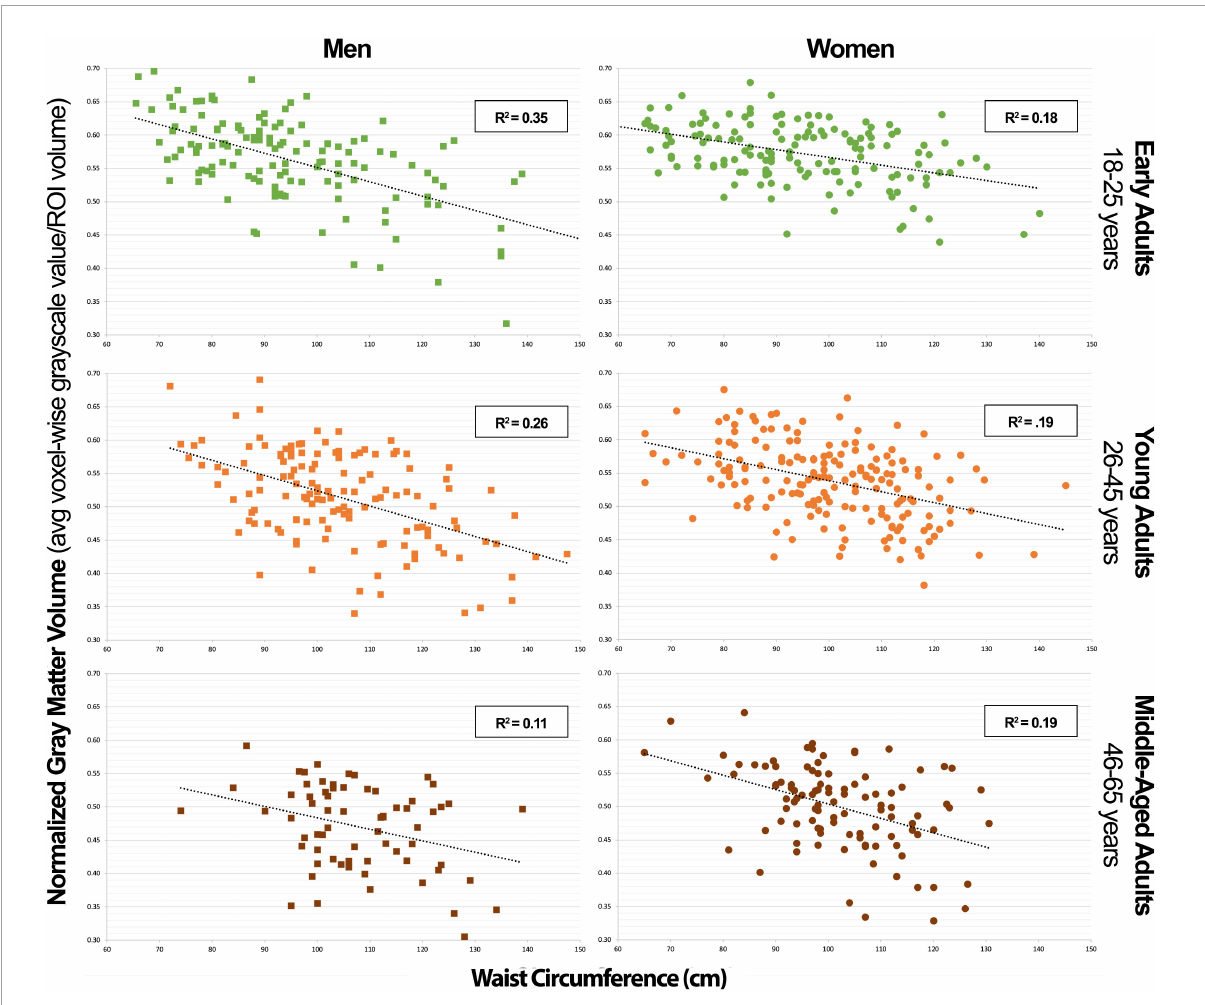
FIGURE3 Combined neural signature of metabolic syndrome gray matter volume vs. waist circumference scatterplot